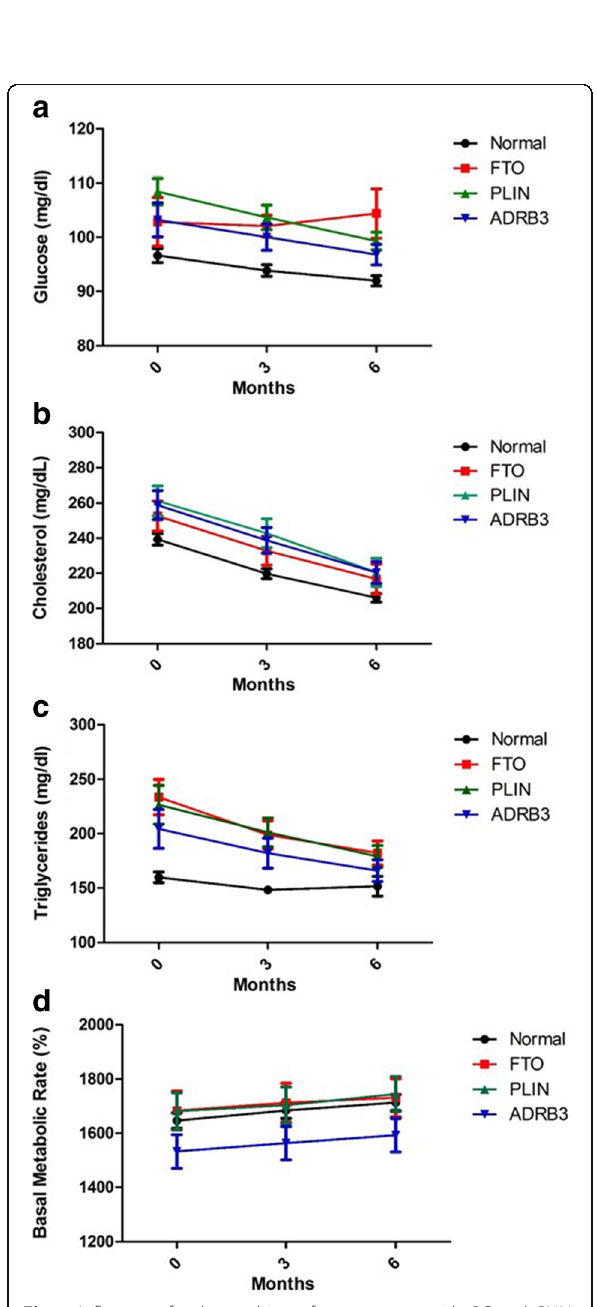
Fig. 5 Influence of polymorphism after treatment with GC and GNN on metabolic markers levels. Glucose ( a ), Cholesterol ( b ), Triglycerides ( c ) and Basal metabolic rate ( d ). PLIN: 11482G> A, FTO: rs9939609 A/T and ADRB3: Trp64Arg